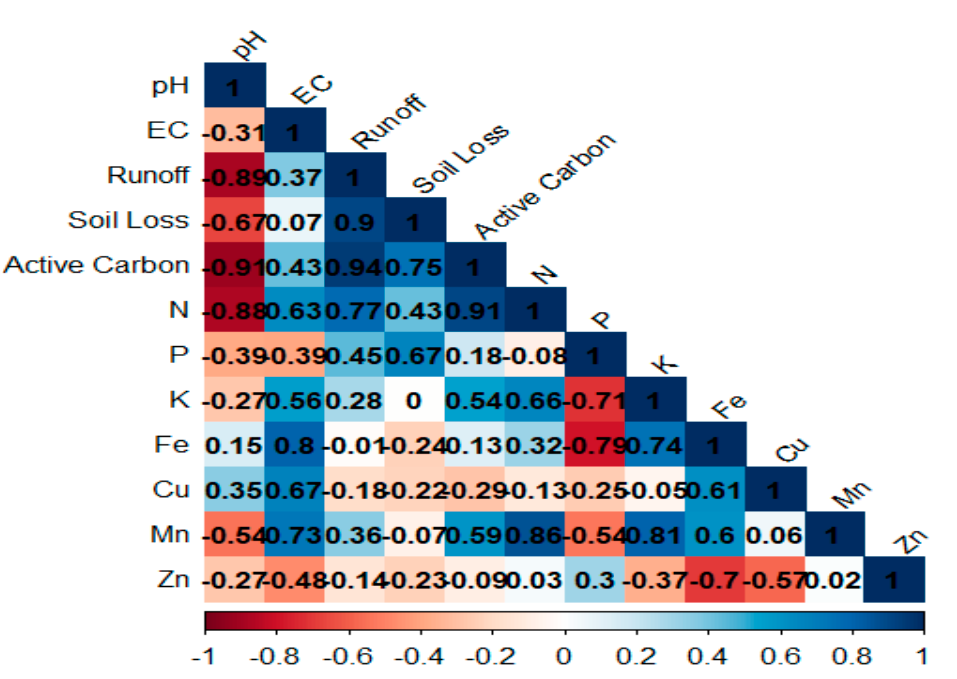
Figure 11. Pearson’s correlation coefficients between the means of different parameters. Note: Color coding: from white to blue, increasingly greater positive correlation; from white to red, increasing greater negative correlation; white or no color, non-significant correlation (at p < 0.05).